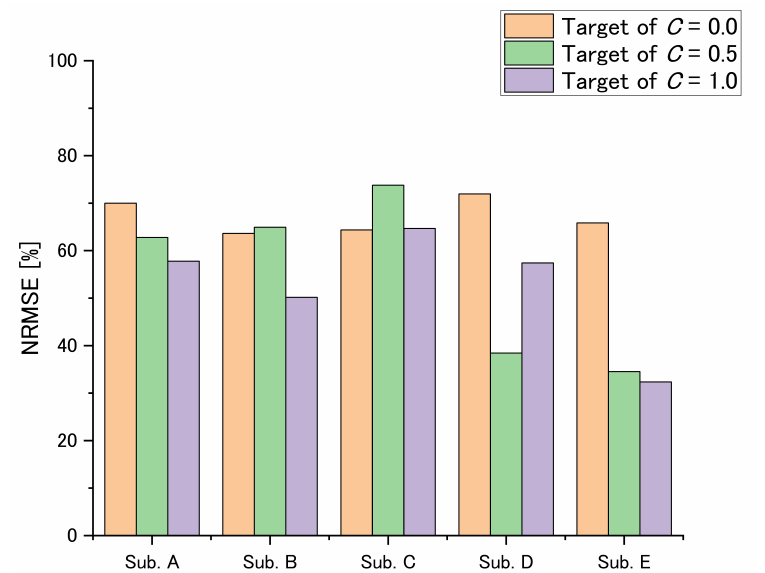
Figure 10. The results of